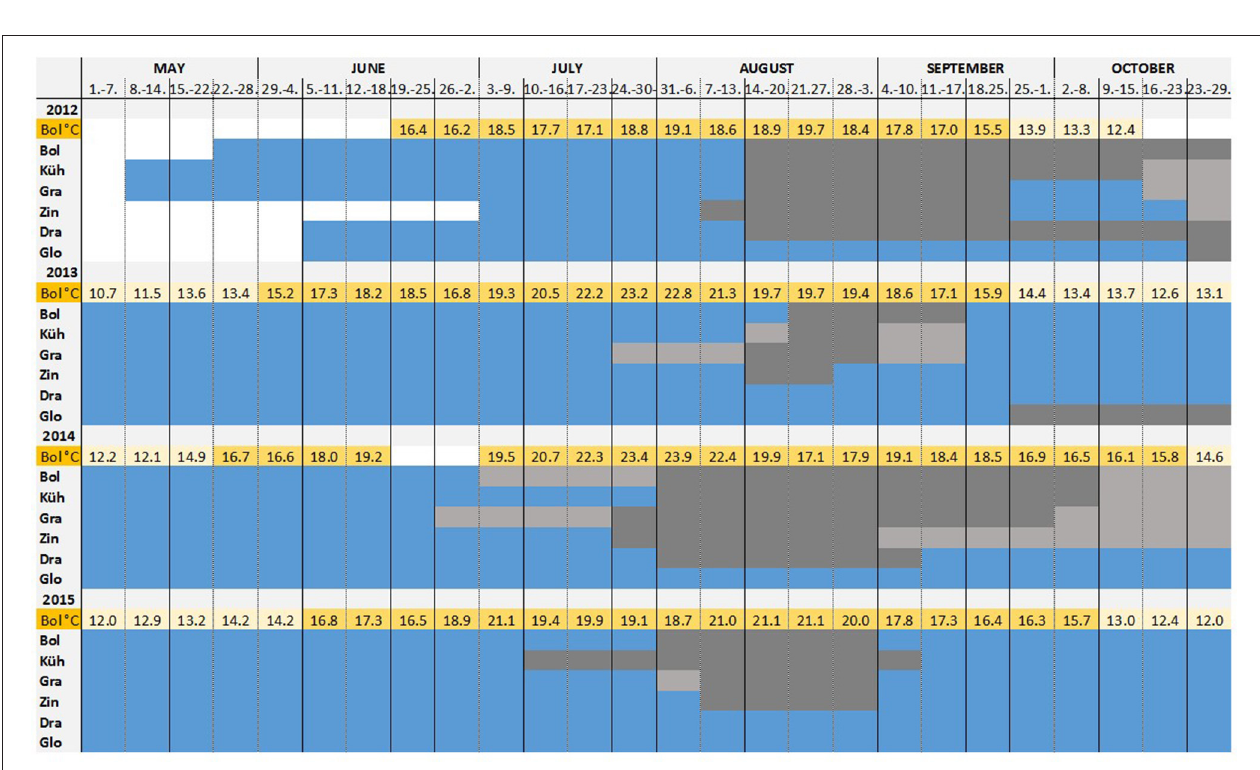
FIGURE 6 | Time of larval settlement: During each month in summer, a test panel was collected and replaced by a new one. Periods of high, low and no Teredo navalis recruitment are shown. The mean temperature per week measured at Boltenhagen is indicated above the bars, showing the temperature variation during the summers of 2012–2015. Temperatures above 15 ◦ C are highlighted. The period of low recruitment is defined as the period when less than 10 percent of total larvae of the respective year and sampling location settled. no recruitment main recruitment period low recruitment period no